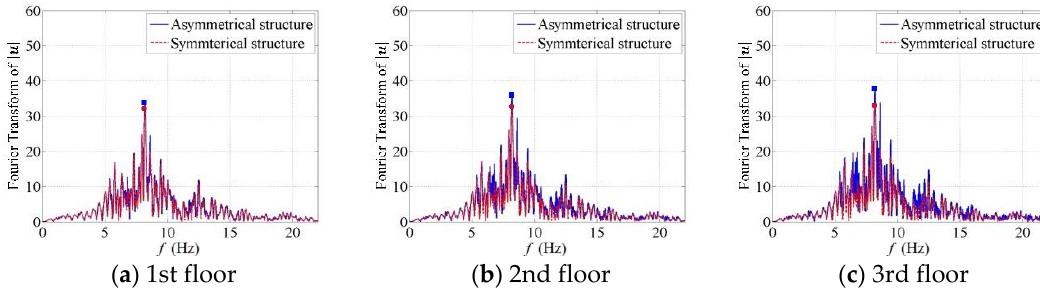
Figure 37. Displacement frequency spectra of the asymmetric SMART 2013 structure and the hypothetical symmetric structure due to the Northridge earthquake (Run 19); Displacement amplitude (|𝒖| = √𝒖 𝒙𝟐 + 𝒖 𝒚𝟐 ) sampled at point D.